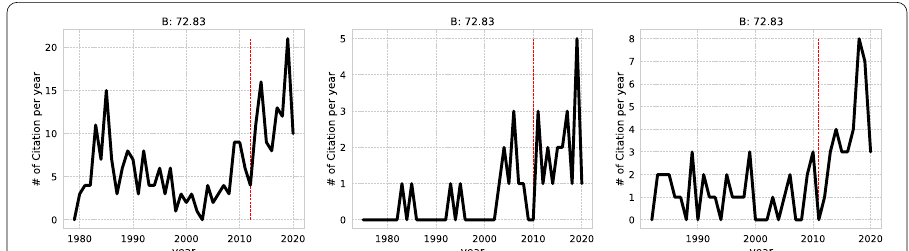
Fig. 6 Yearly citation curve of the lowest B-score in SB papers. The dotted line indicates the year t a when the paper was